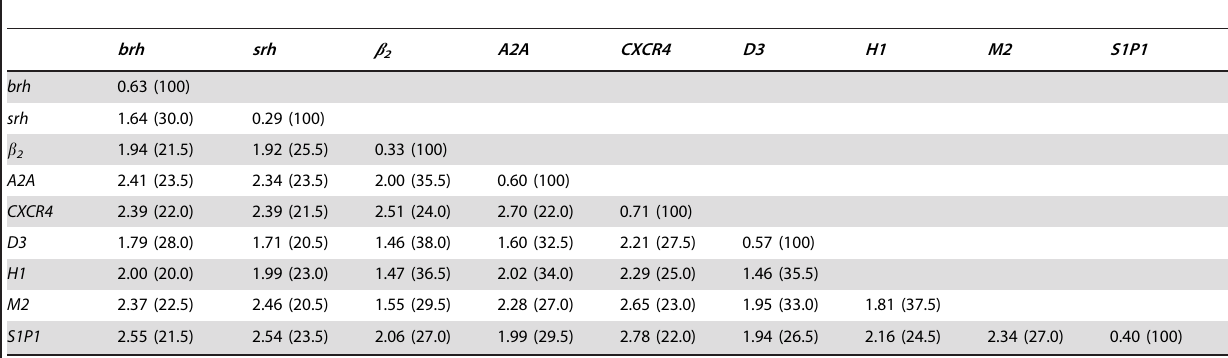
Table 1. Averaged rmsds (A˚) of the 7TM bundle pairs in the inactive state for class A GPCRs of known